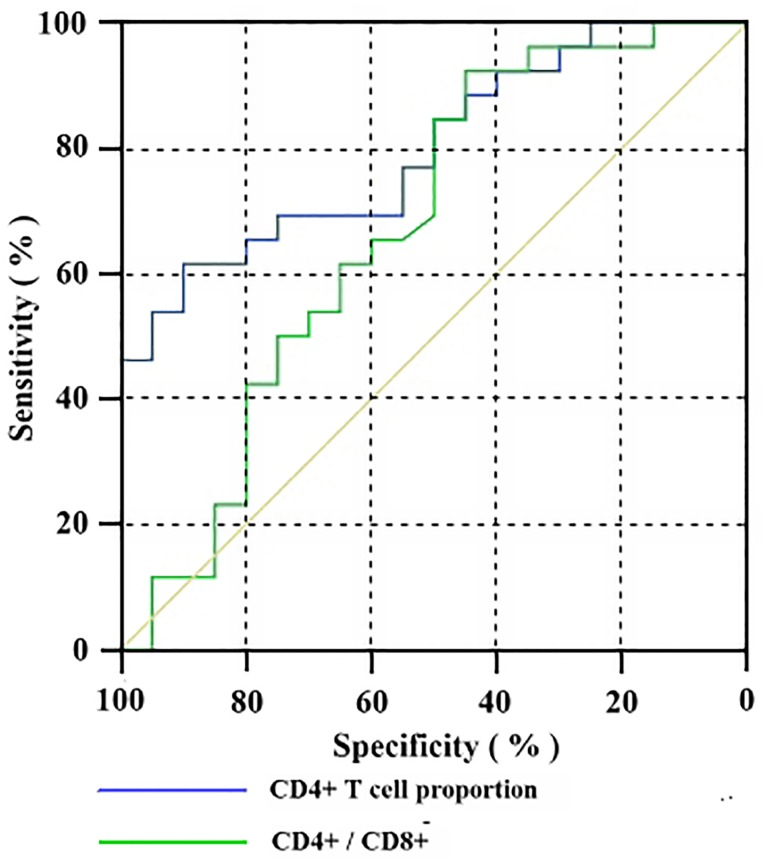
ROC curve of CD4+ T cell proportion versus CD4+/CD8+ ratio in predicting POF.